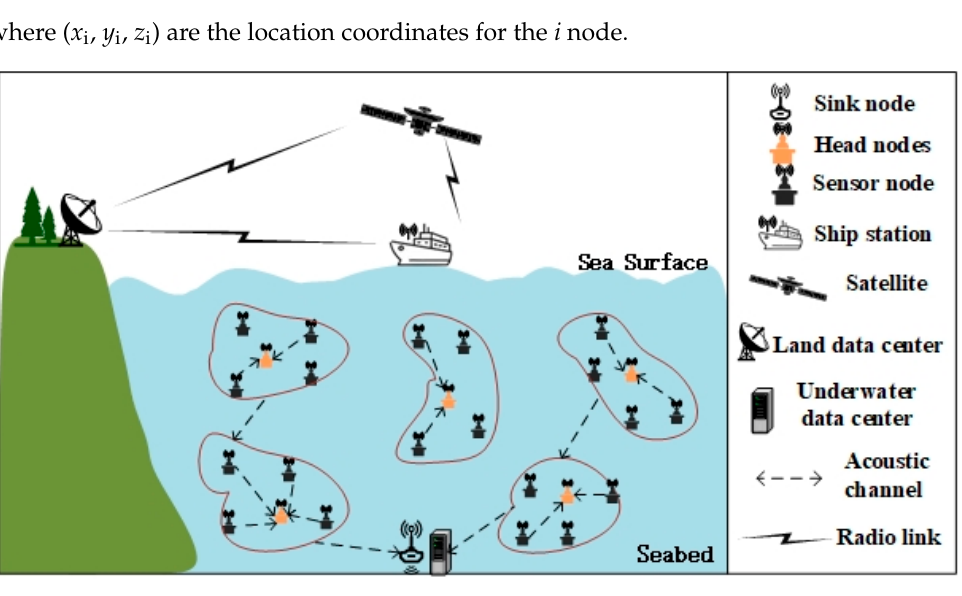
Figure 1. Network model.